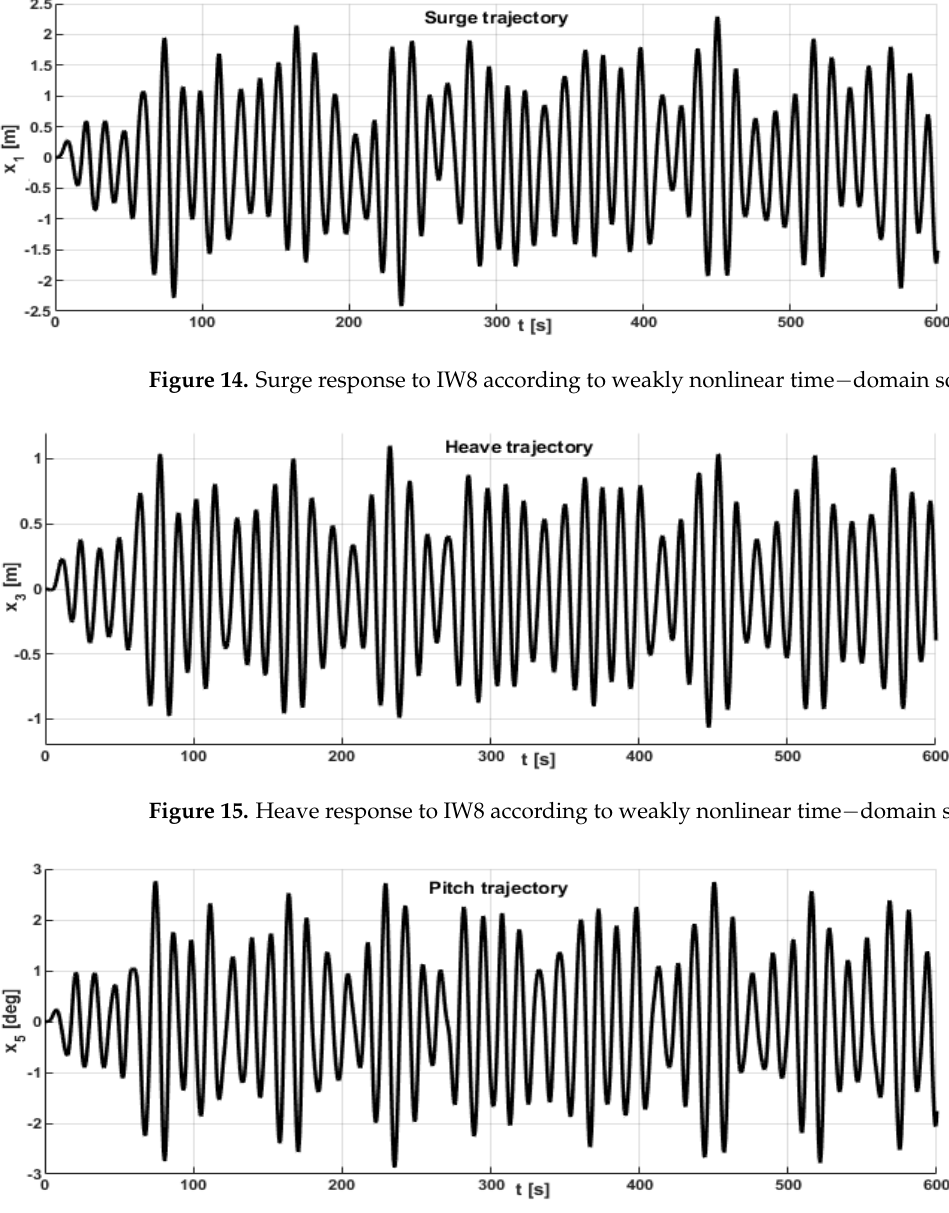
Figure 13. IW8 wave series according to weakly nonlinear time − domain solver (Hs = 10.0 m, Tp = 14.0 s).